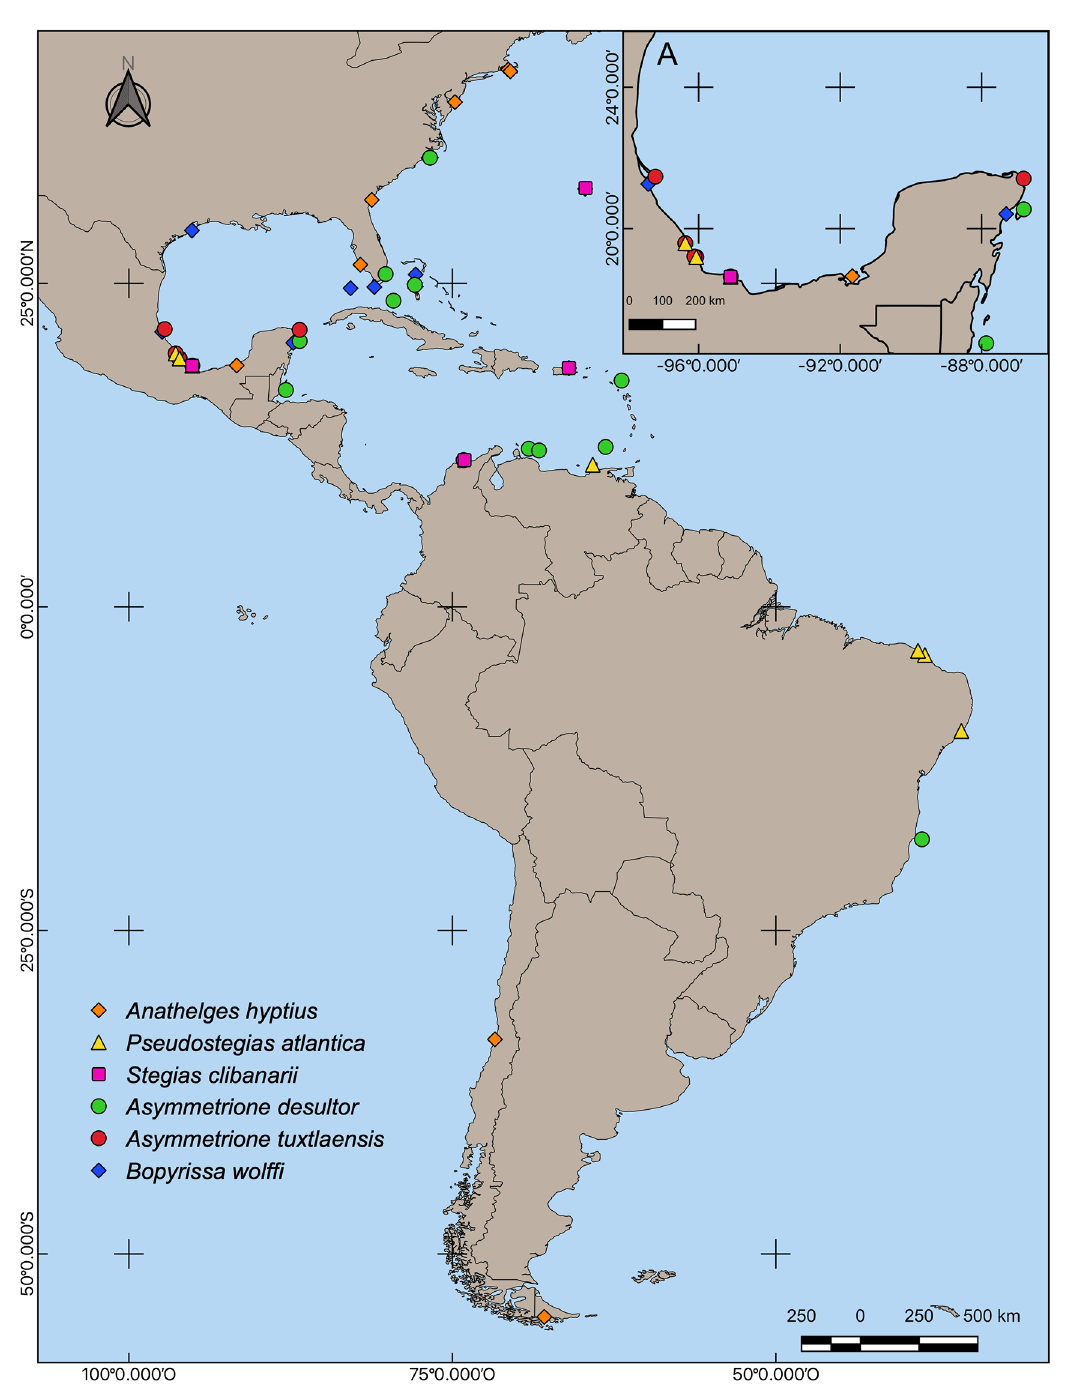
Fig. 1. Distribution along the American continent of five bopyrid species that parasite hermit crabs recorded in the Mexican Atlantic. A . Detail of the Atlantic coast of